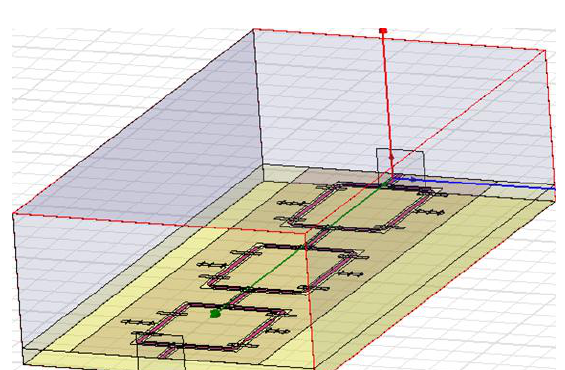
Figure 11: Schematic of the 3-bit integrated phase- shifter structure built in HFSS.